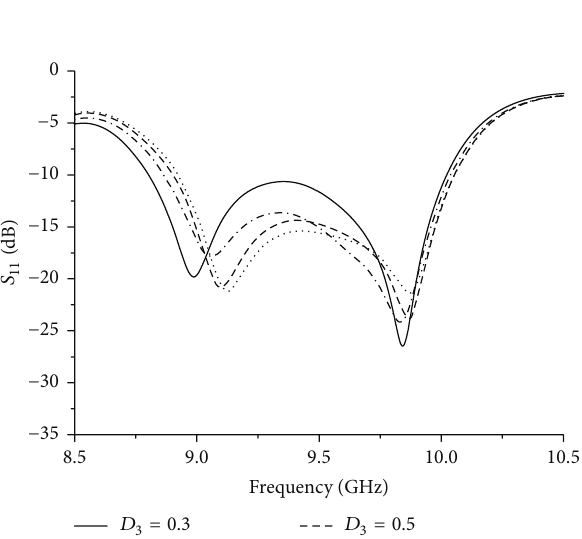
Figure 12: 𝑆 11 when 𝐷 2 varies.